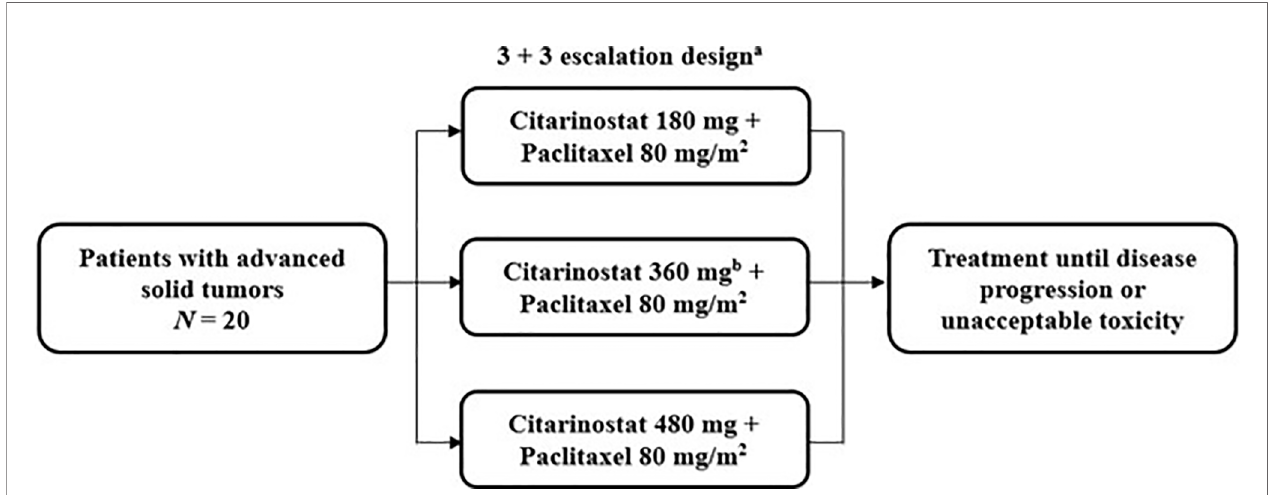
FIGURE 1 | Study design of the phase Ib trial of citarinostat plus paclitaxel in patients with advanced solid tumors. a 28-day cycles with citarinostat administered orally once daily on days 1 to 21 at all doses and paclitaxel administered intravenously on days 1, 8, and 15. b An additional 360-mg cohort was allowed if the maximum tolerated dose was not